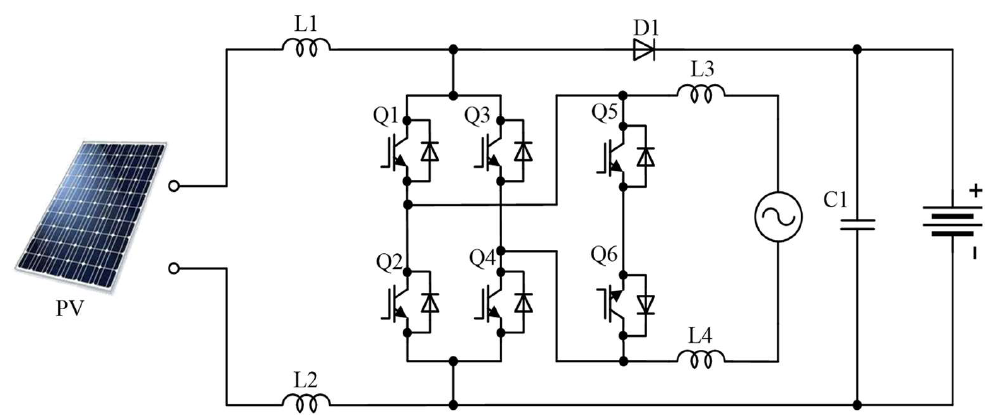
Figure 12. Hybrid Transformerless PV Converter [65].